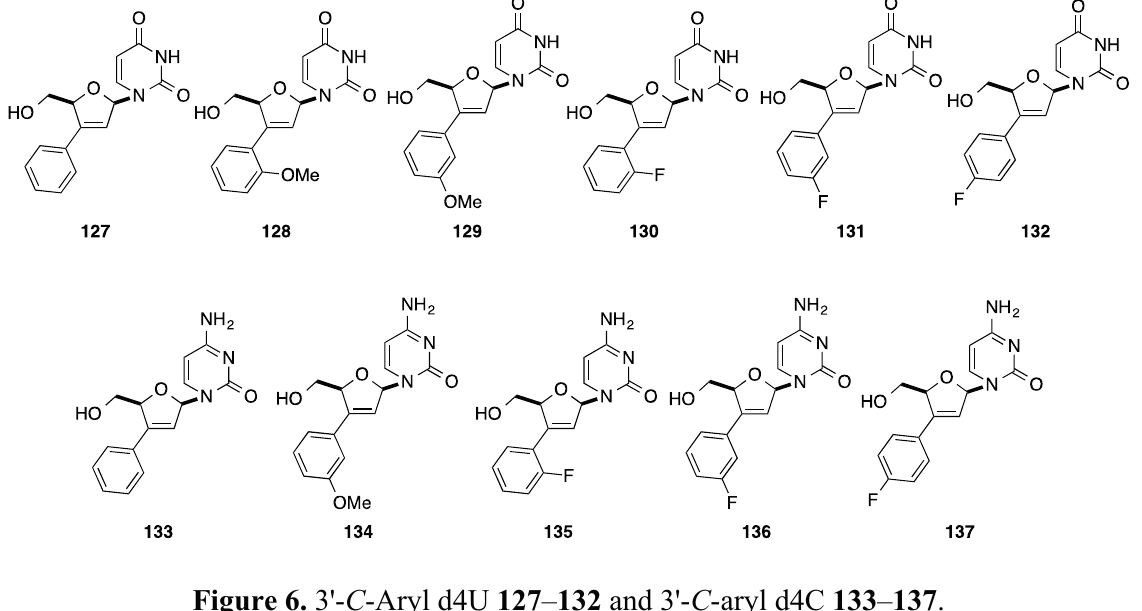
Figure 6. 3'- C -Aryl d4U 127 – 132 and 3'- C -aryl d4C 133 – 137